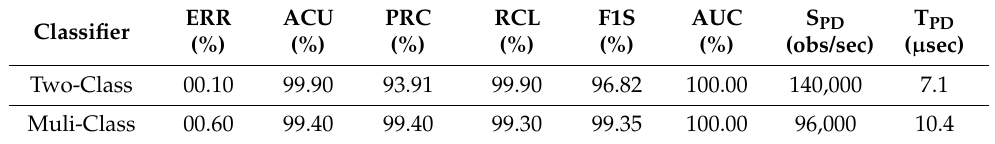
Table 3. Summary of performance indicator metrics obtained for all predictive